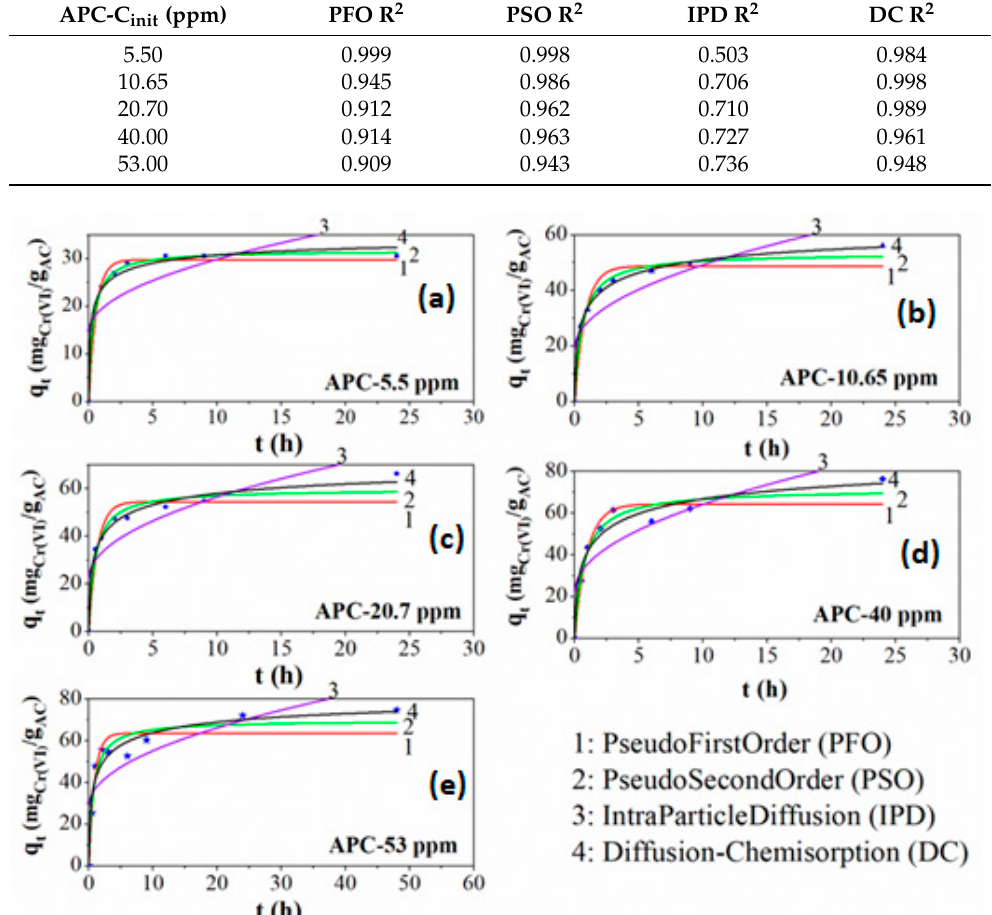
Figure 12. Fitted curves of four different kinetic models (i.e., (1) pseudo first order (PFO), (2) pseudo second order (PSO), (3) intra particle diffusion (IPD), (4) diffusion–chemisorption (DC)), upon experimental kinetic datasets of five different Cr(VI) initial concentrations (i.e., ( a ) 5.5 ppm, ( b ) 10.65 ppm, ( c ) 20.7 ppm, ( d ) 40 ppm, ( e ) 53 ppm) for the APC material.